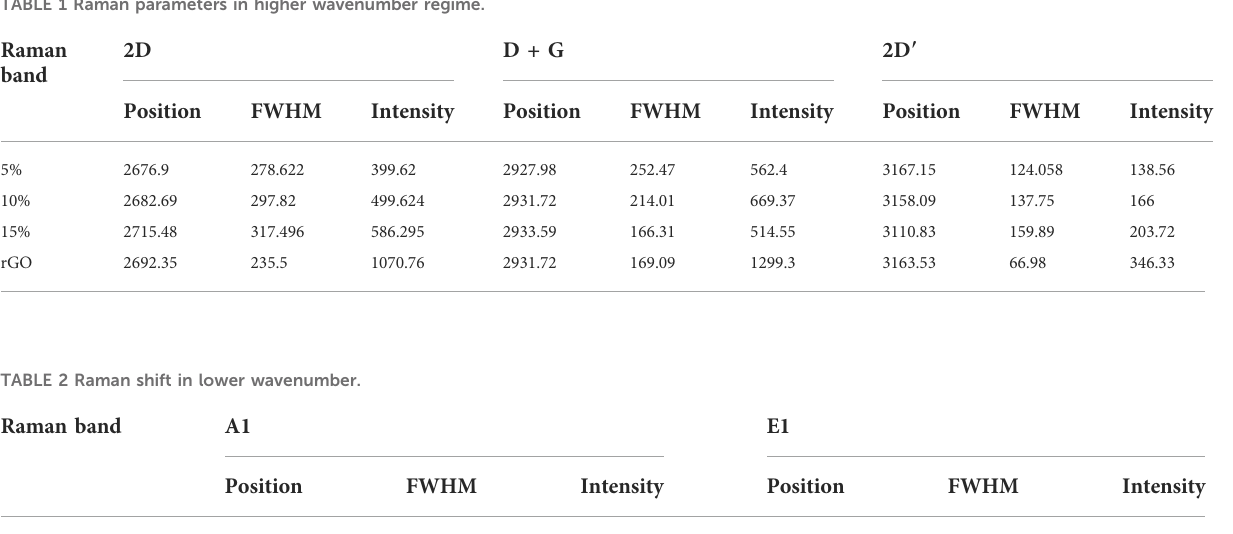
TABLE 1 Raman parameters in higher wavenumber regime.